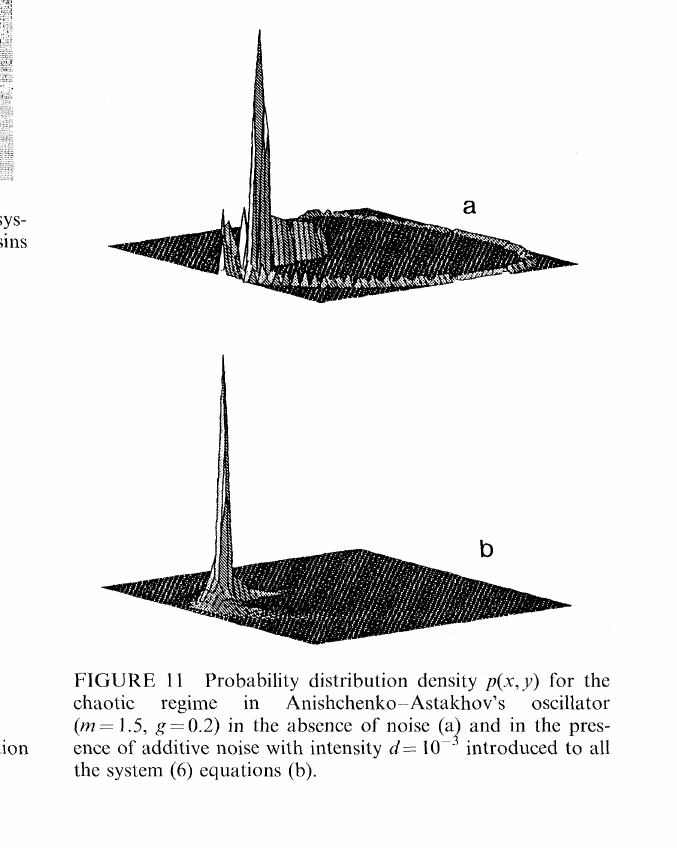
FIGURE 10 Lyapunov exponents )1 and X as a function of parameter m (g 0.2) for system (6).